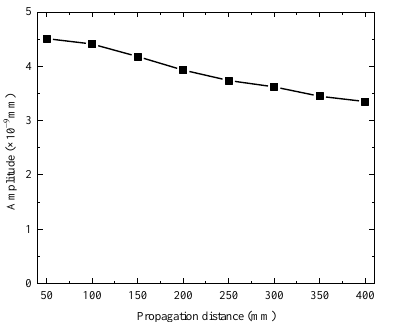
Figure 23. Attenuation of EMUS surface wave with propagation distance.